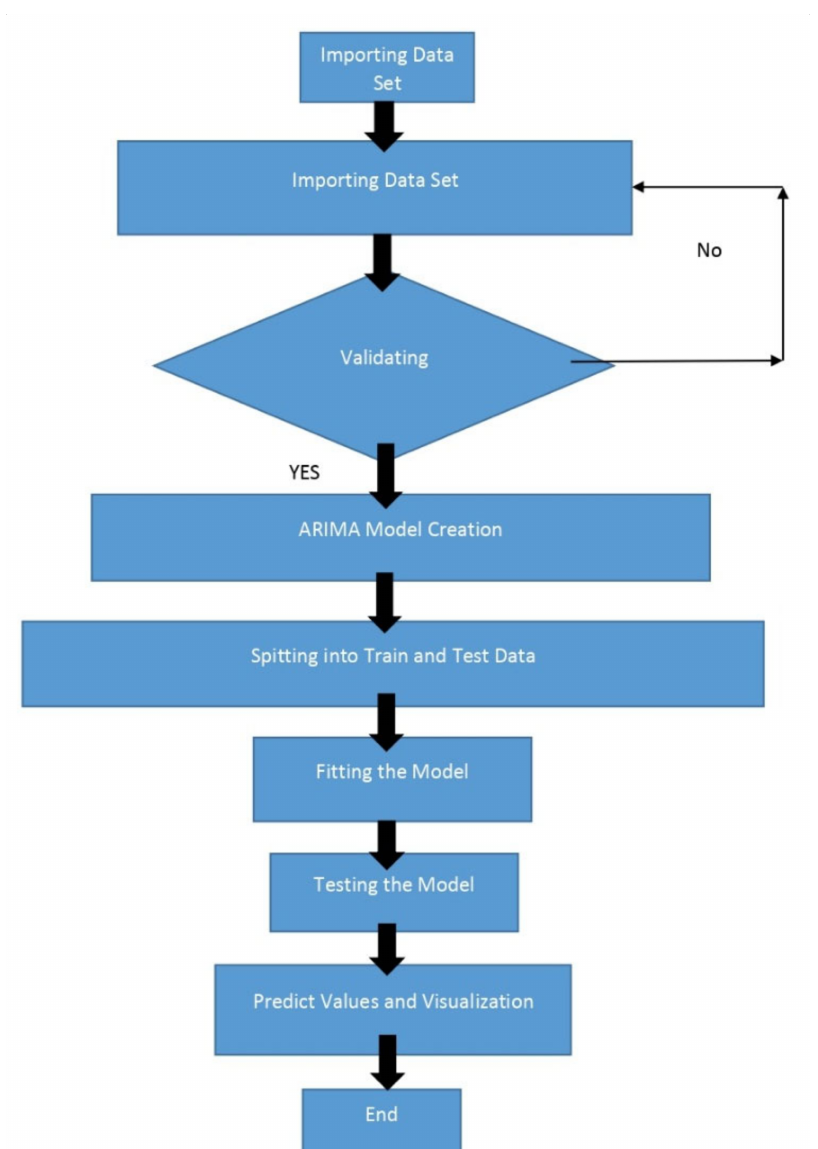
Figure 3. Procedural flow chart for predicting results through the machine learning